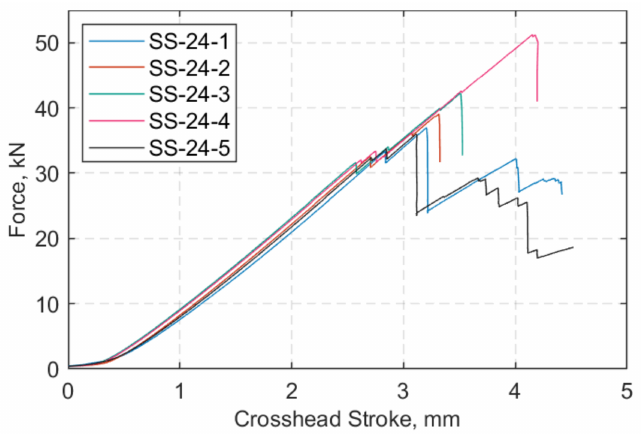
Figure 13. Force (kN) vs. crosshead stroke (mm) at 24 ◦ C.